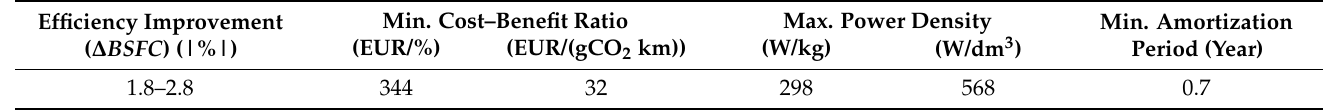
Table 6. Overall results of the TEG-simulation environment for the natural gas HDV.